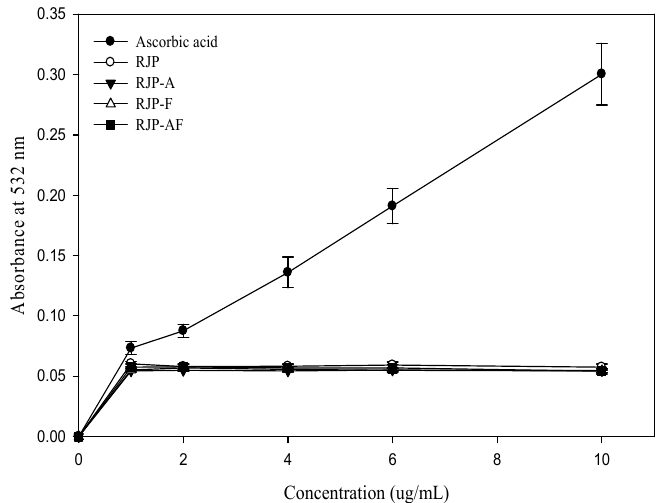
Figure 3. Effect of RJP and RJP hydrolysate on DNA damage induced by bleomycin-Fe 3+ .